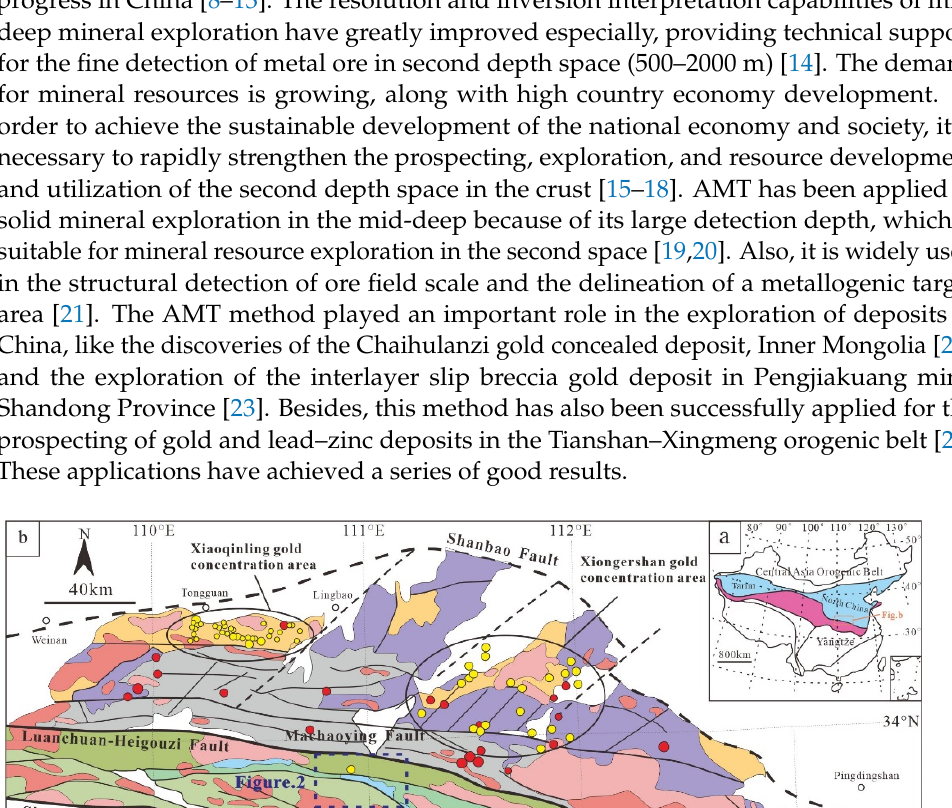
Figure 1. Geological map of the Eastern Qinling area on the southern margin of the NCC showing: ( a ) the position of the study area and distribution of Au deposits; ( b ) the position of the Eastern Qinling and other tectonic units, and distribution of Au deposits (Modified from